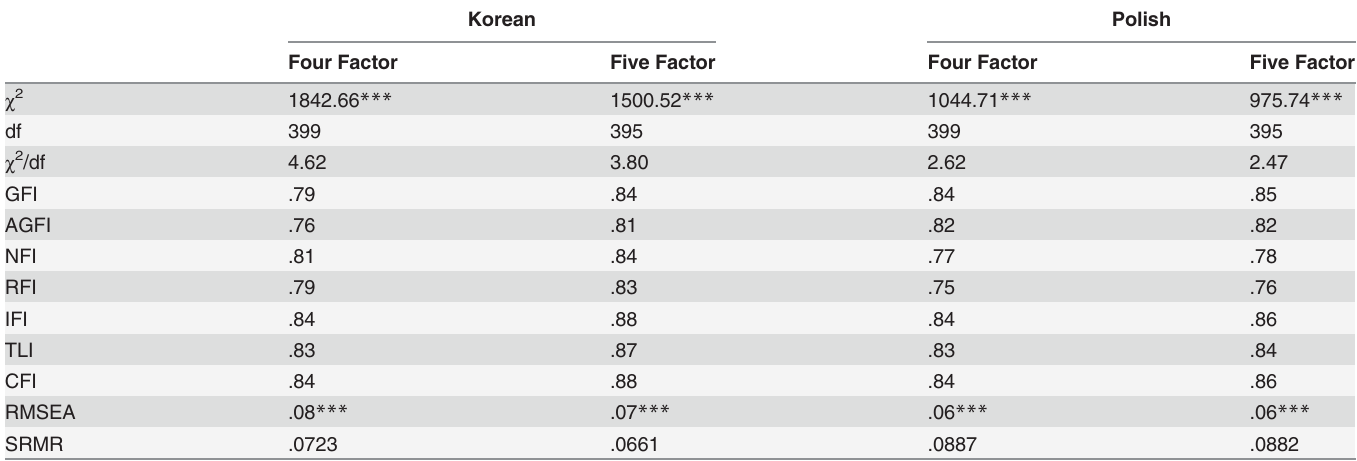
Table 13. Goodness of Fit Statistics for Con fi rmatory Factor Analysis Results for Fully Correlated Four and Five Factor Models for the ESI-R for Korean and Polish Samples. Korean Polish Four Factor Five Factor Four Factor Five Factor 1842.66 ***